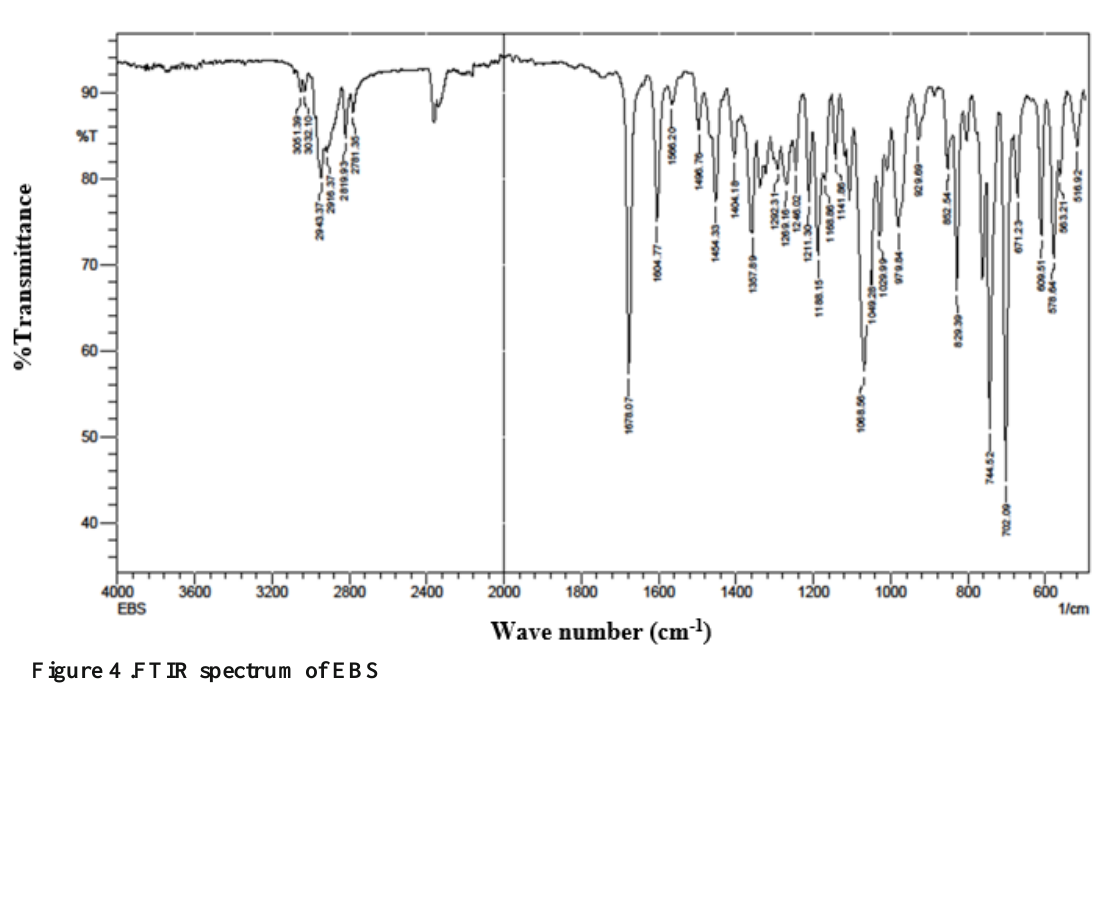
Figure 3. Comparative in-vitro dissolution profile of the pure EBS, SSD16 and physical mixture of SSD16 (PM) in 0.1N HCl at 37±0.5 °C.